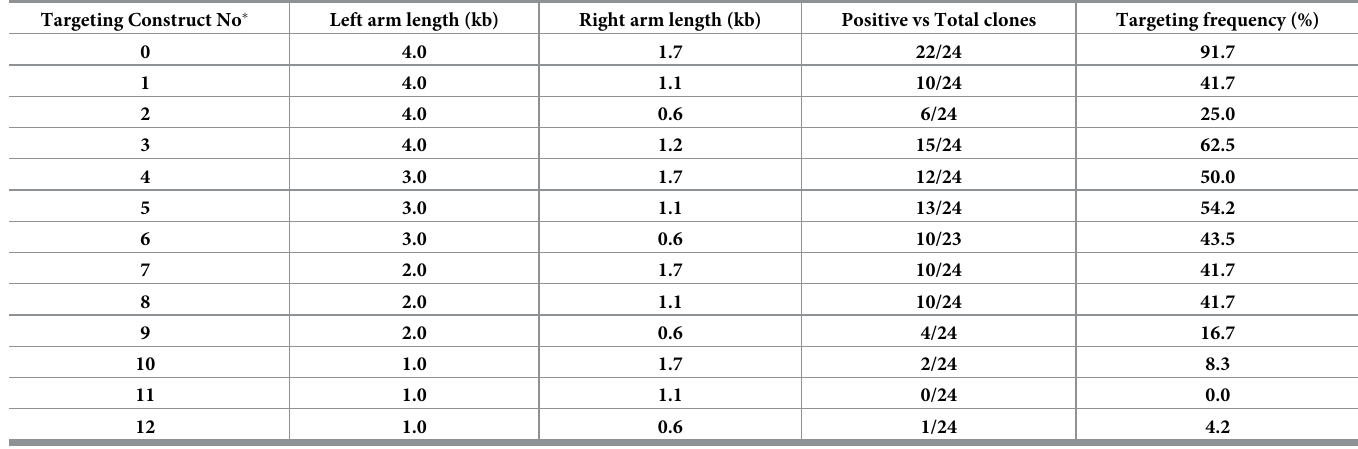
Table 5. Summary of the HR frequency for each targeting